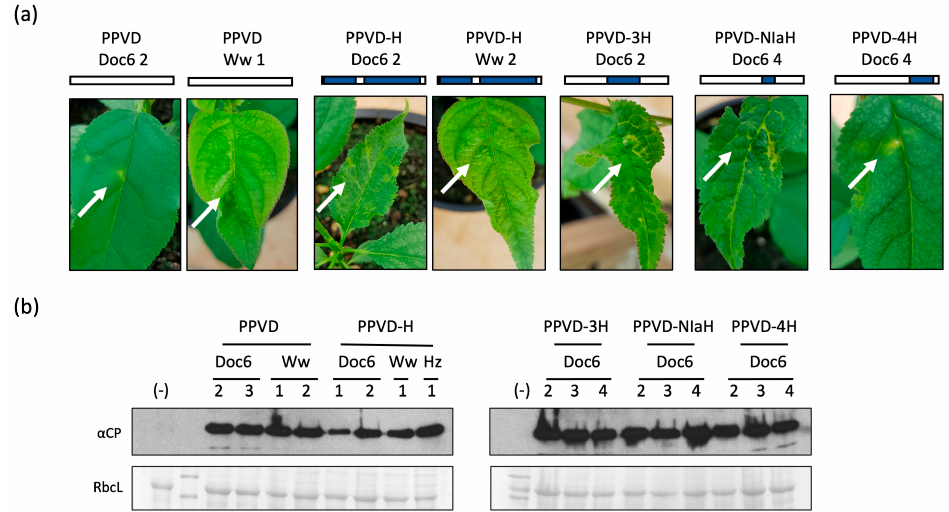
Figure 3. Testing of PPVD-3H, PPVD-NIaH and PPVD-4H in ‘Docera 6 ′ -resistant plants. ( a ) Images taken at 14 dpi from leaves showing different symptoms depending on the inoculated virus; Doc6, Ww and Hz correspond to ‘Docera 6 ′ (resistant) and ‘Weiwa’ and ‘Hz’ (susceptible) plants, respectively; number following the type of plant indicates the number of the plant; small scheme of the viral constructs is depicted: PPVD and PPVD-H sequences are shown in white and in blue, respectively; white arrows mark the observed symptoms. ( b ) Anti-CP immunoblots of protein extracts from tissue collected at 20 dpi from the upper non-inoculated leaves of the different plants; numbers on top of each lane correspond to the number of the plant; negative control, marked with ( − ), corresponds to a healthy ‘Docera 6 ′ plant; a Ponceau red-stained blot (RbcL) is shown below each membrane as loading control.